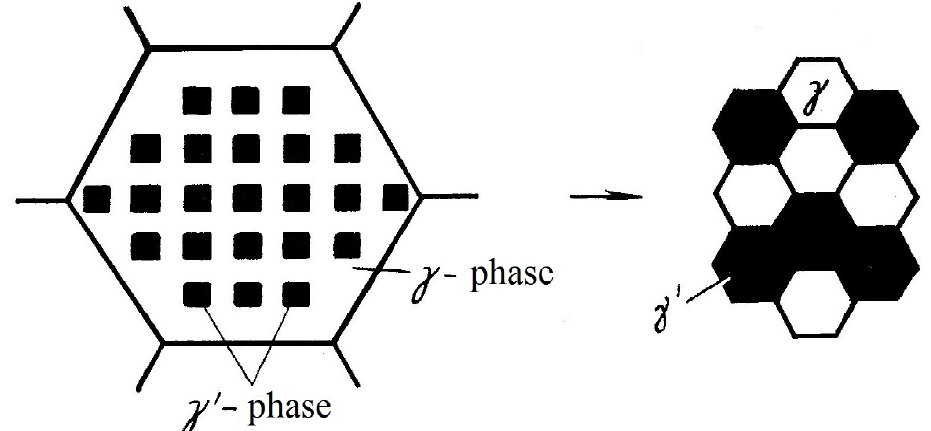
Fig. 4. Scheme illustrating the structure transformation in heat-resistant Ni-based alloys to transit them in the SP